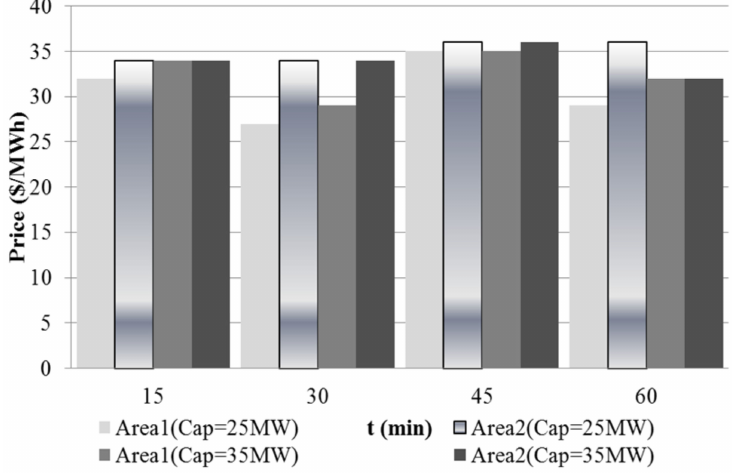
Figure 5. Impact of tie-line capacity on balance price.